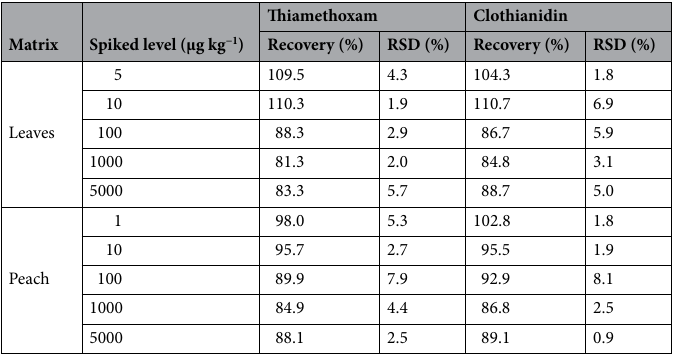
Table 3. Recoveries and RSDs of thiamethoxam and clothianidin in peaches samples at different fortification levels (n = 5).